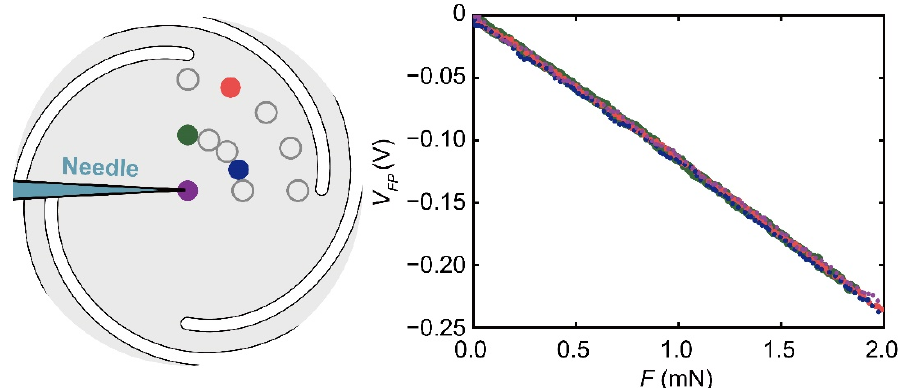
Figure 11. Some examples of the relationship between F and V FP . The color of each point in the left diagram corresponds to the color in the right graph.